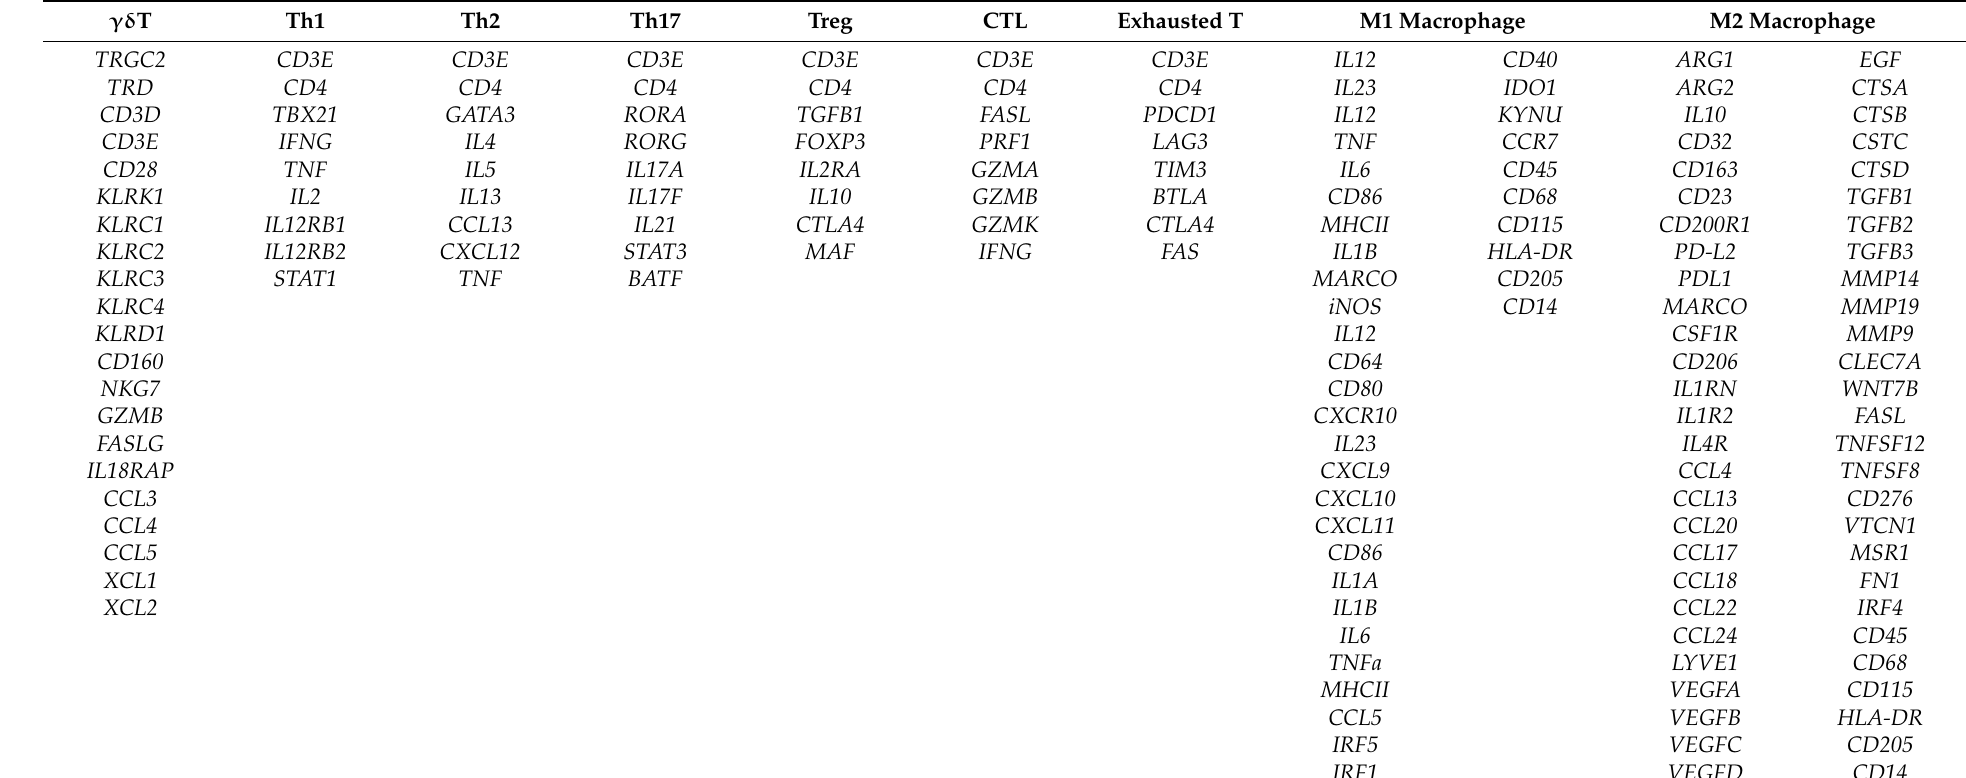
Table 2. List of immune gene signatures for gene set enrichment